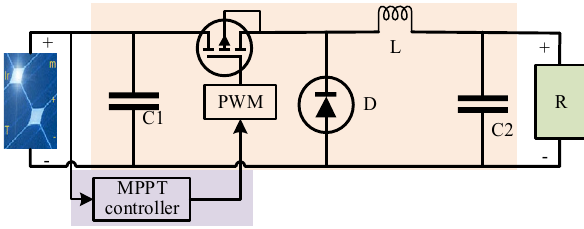
Figure 8. Photovoltaic system structure diagram.